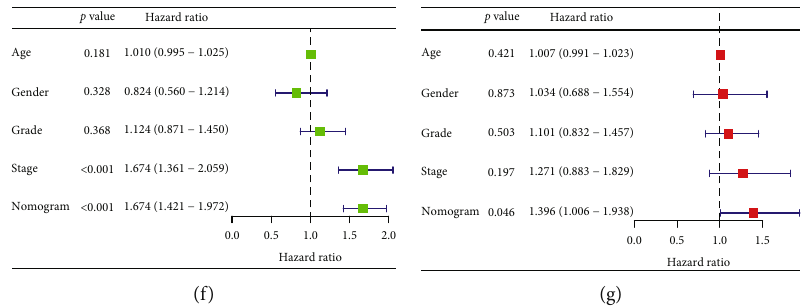
Figure 10: Predicting survival rates for HCC patients after one year, three years, and fi ve years using the nomogram. (a) The nomogram model was formed to predict the survival rates of HCC patients in the TCGA cohorts. (b) Calibration curves of the nomogram. (c – e) The ROC curve explored the prognostic performance of the nomogram model. (f, g) Univariate and multivariate Cox analysis of the nomogram and clinical